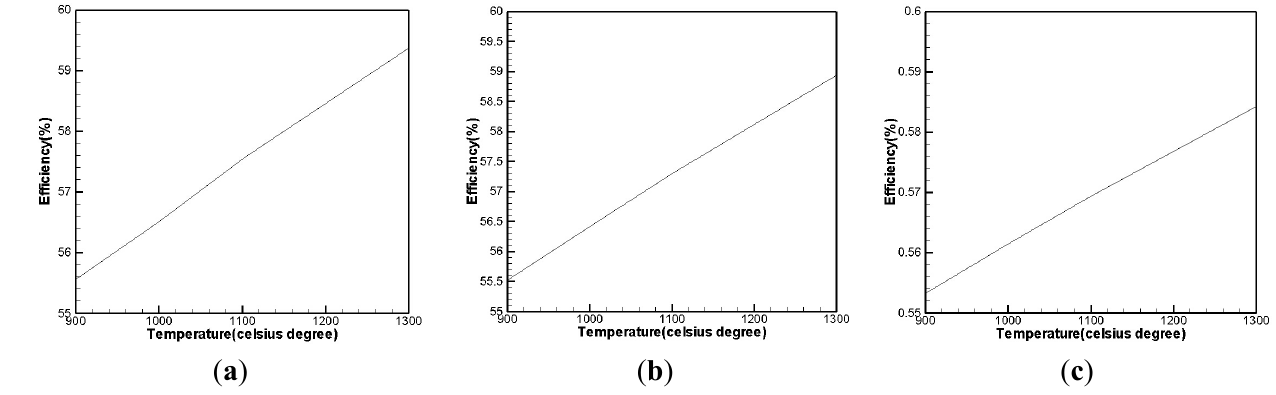
Figure 13. Effect of HPT inlet temperature on efficiency While IPT inlet temperature is: ( a ) 900 °C; ( b ) 1100 °C; ( c ) 1300